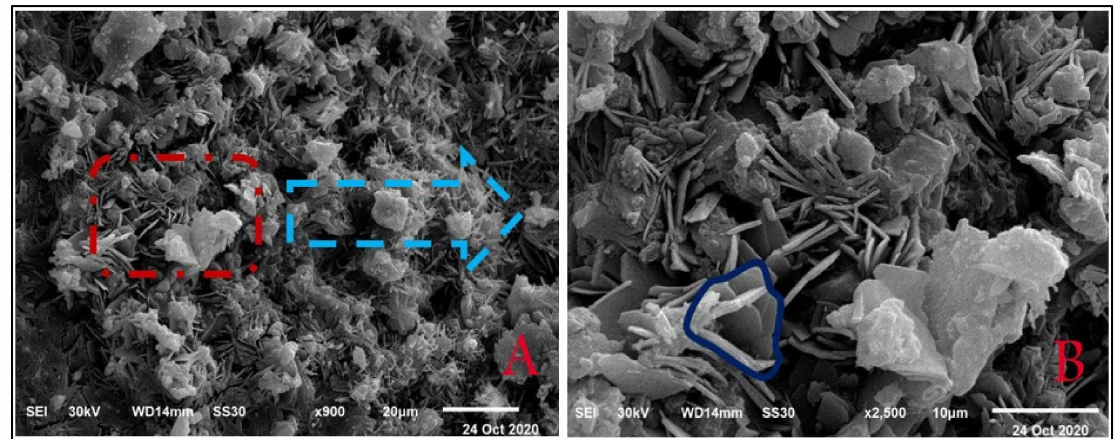
Figure 25. SEM of mix Z1 under 500 ◦ C fire exposure at 180 days: ( A ) at a scale of 20 µ m, ( B ) at a scale of 10 µ m. The FS chemical formula is 3CaO · Al 2 O 3 · CaC l2 · 10H 2 O. In cemented systems, the chloride binding ability is controlled by aluminum silicate phase (C 3 A) and C 4 AF content; chlorides such as NaCl are bound by C 3 A and C 4 AF to form FS. The latter is formed either entirely or partly by iron when aluminum is replaced or as a ferrite phase hydration element. Along with the volume expansion of ettringite (Aft), during the formation of hydrate the volume of solid-phase FS expands and is stable